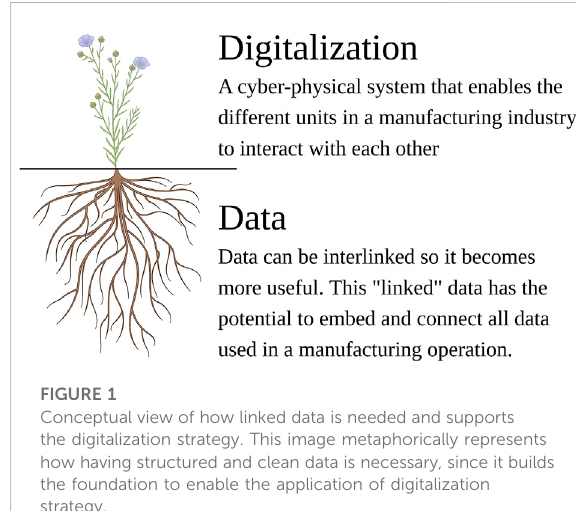
FIGURE 1 Conceptual view of how linked data is needed and supports the digitalization strategy. This image metaphorically represents how having structured and clean data is necessary, since it builds the foundation to enable the application of digitalization